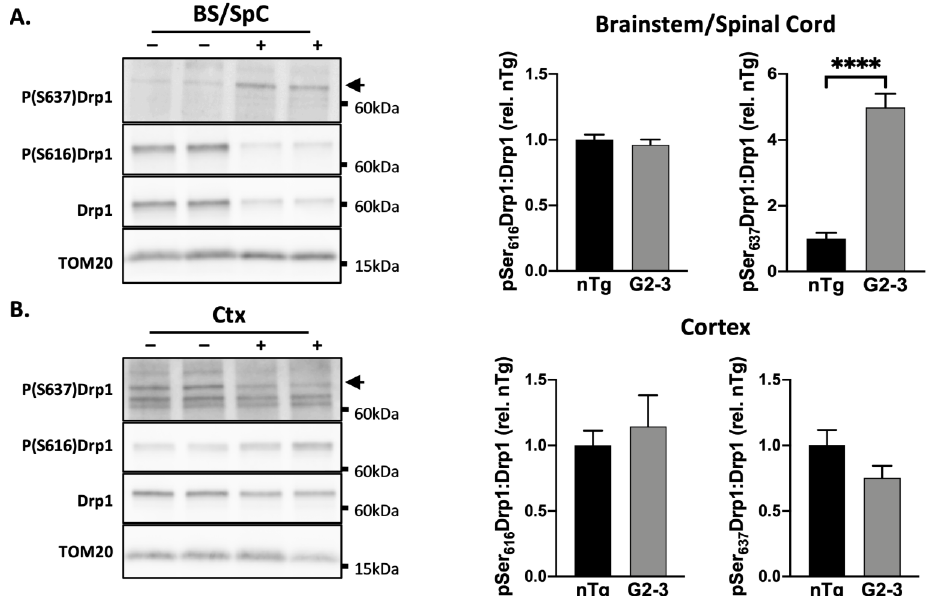
Figure 3. Phosphorylation pattern of Drp1 in brain areas with α S pathology is altered to favor reduced mitochondrial fission. ( A , B ) Immunoblot analysis of mitochondrial fractions from nTg control (−) and TgA53TG2-3 (+, G2-3) mice for phosphorylated Drp1. Location of the pSer637Drp1 band was identified using N2A cell lysate. Quantification of immunoblots with phosphorylated Drp1 normalized to the total mitochondrial Drp1. ( A ) In the pons, compared to the nTg samples, the G2-3 samples showed increased levels of pSer637Drp1 ( p < 0.0001). ( B ) In the cortex, there is no change in pDrp1 levels compared to the nTg samples using an unpaired t -test with Welch’s correction ( n = 6 per group, mean ± SEM). (**** p < 0.0001).